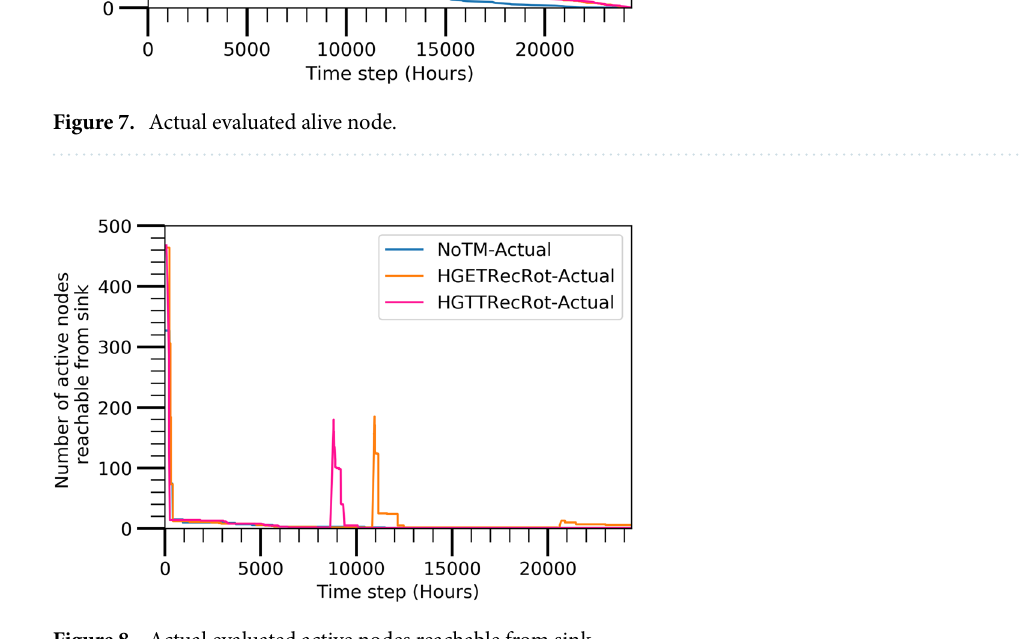
Figure 8. Actual evaluated active nodes reachable from